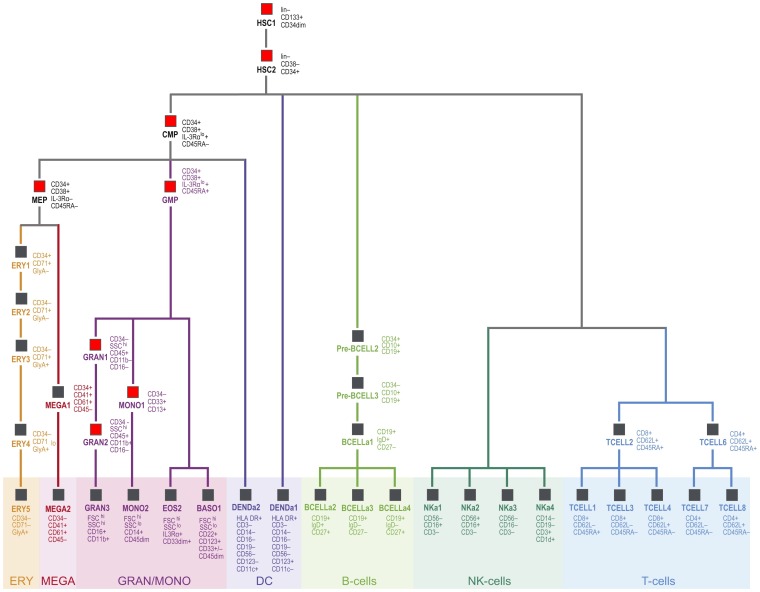
Populations of human hematopoietic cells.38 hematopoietic cell populations are shown with their respective positions in hematopoiesis. Cells called as “progenitors” in the analysis are marked by a red box, “non-progenitor” cells are marked by a gray box. Figure adapted from Novershtern et al. [9].